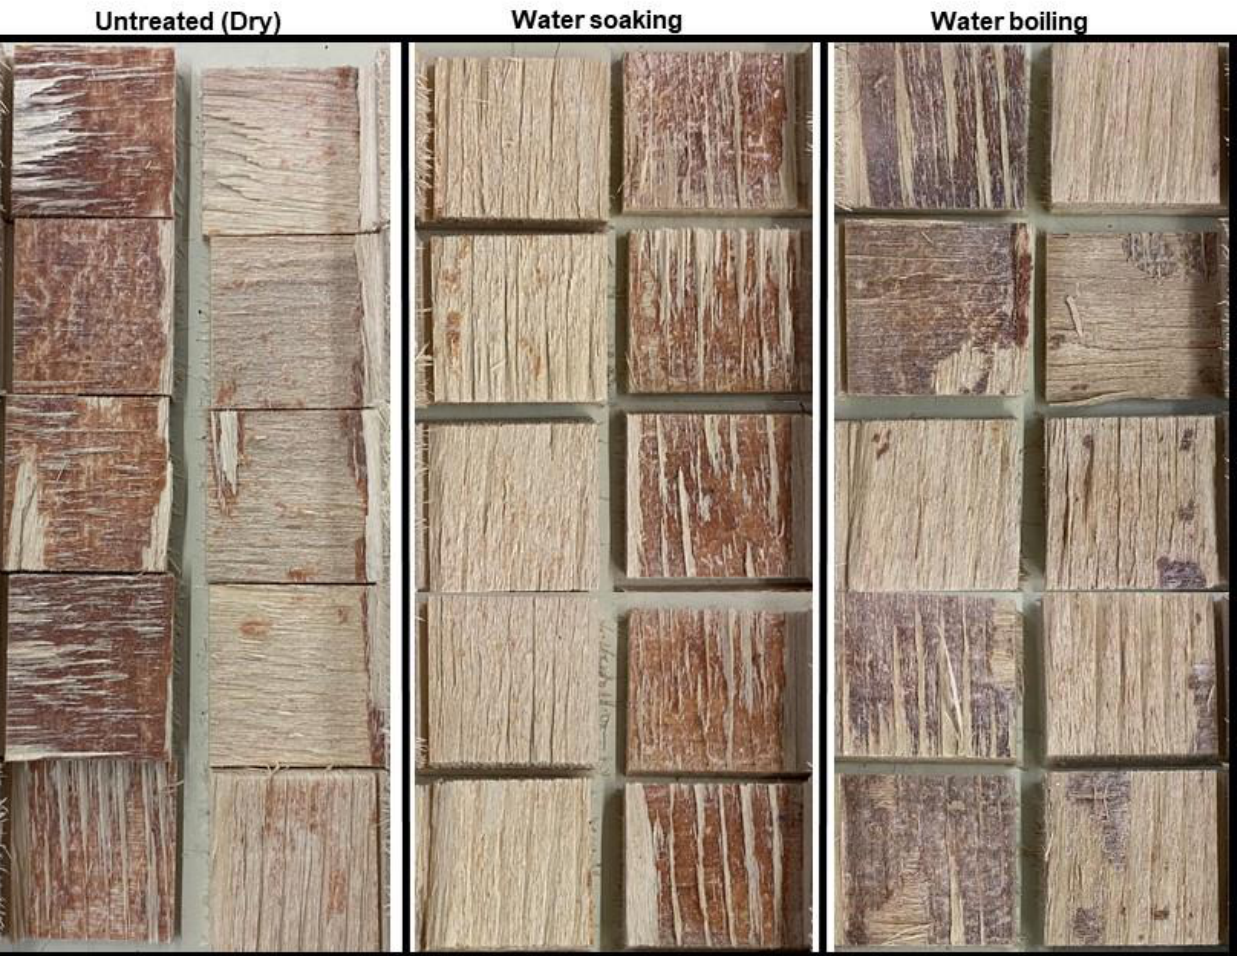
Figure 5. Fractured surface of the plywood bonded with MOC binder after shear strength test.